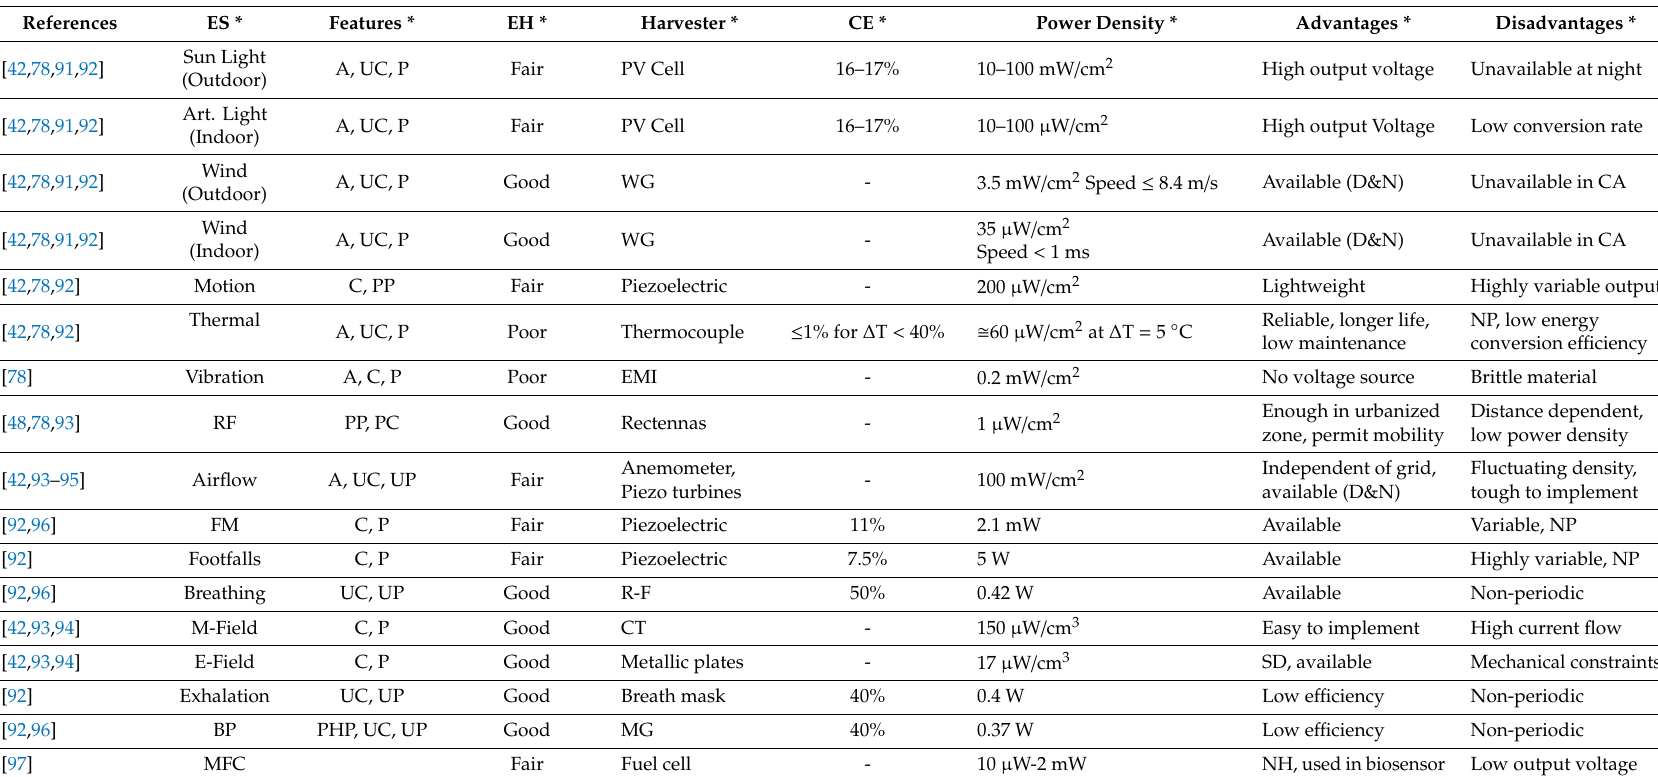
Table 4. Comparative analysis of energy harvesting systems based on di ff erent ambient energy